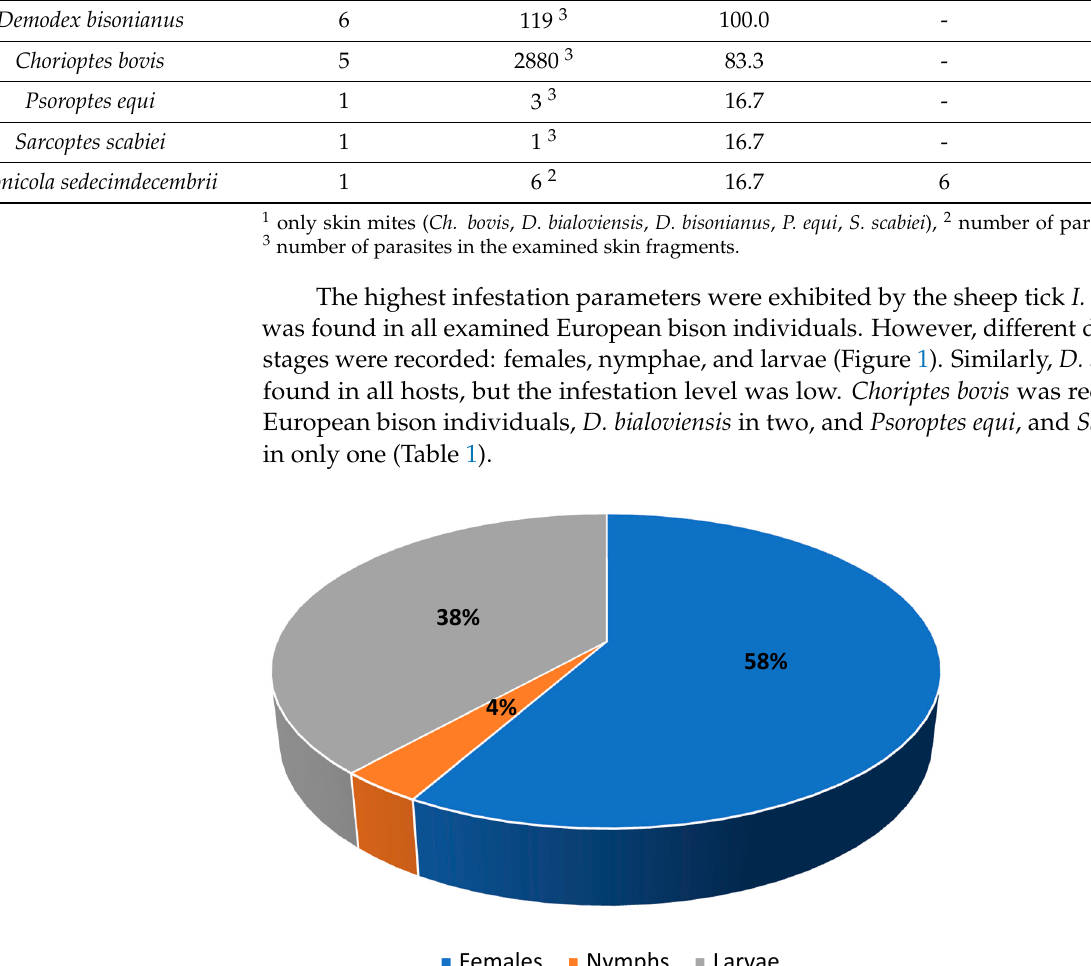
Figure 1. Population structure of Ixodes ricinus .